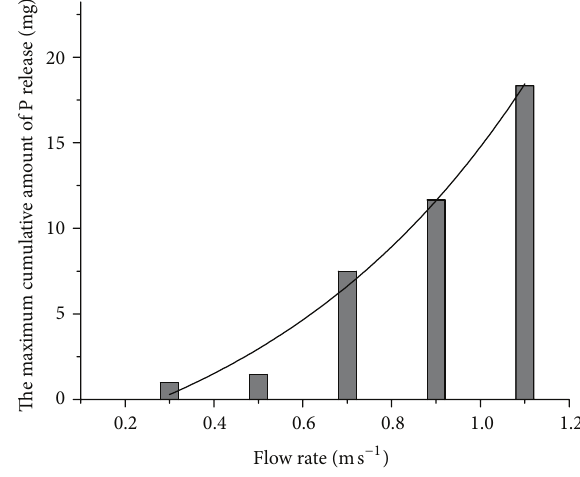
Figure 8: Maximum cumulative amount of P release as a function of flow